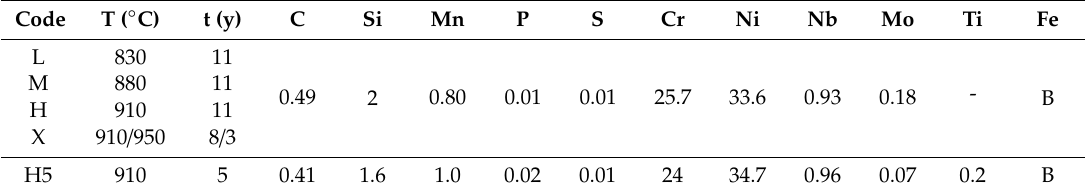
Table 1. Composition (wt%) of the alloys and creep exposure